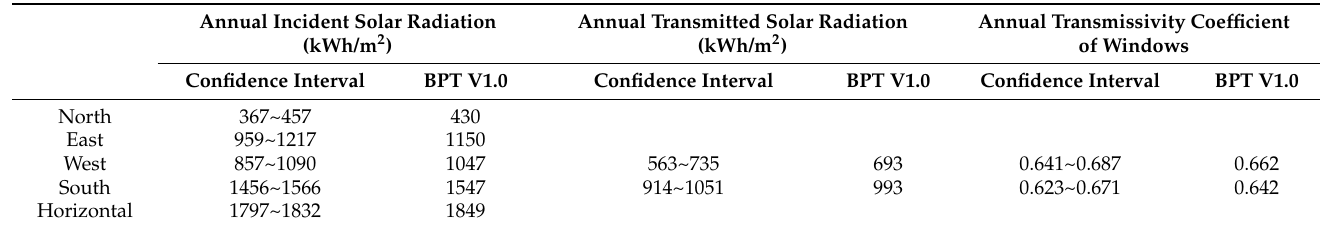
Table 5. Annual incident/transmitted solar radiation and annual transmissivity coefficient of windows.